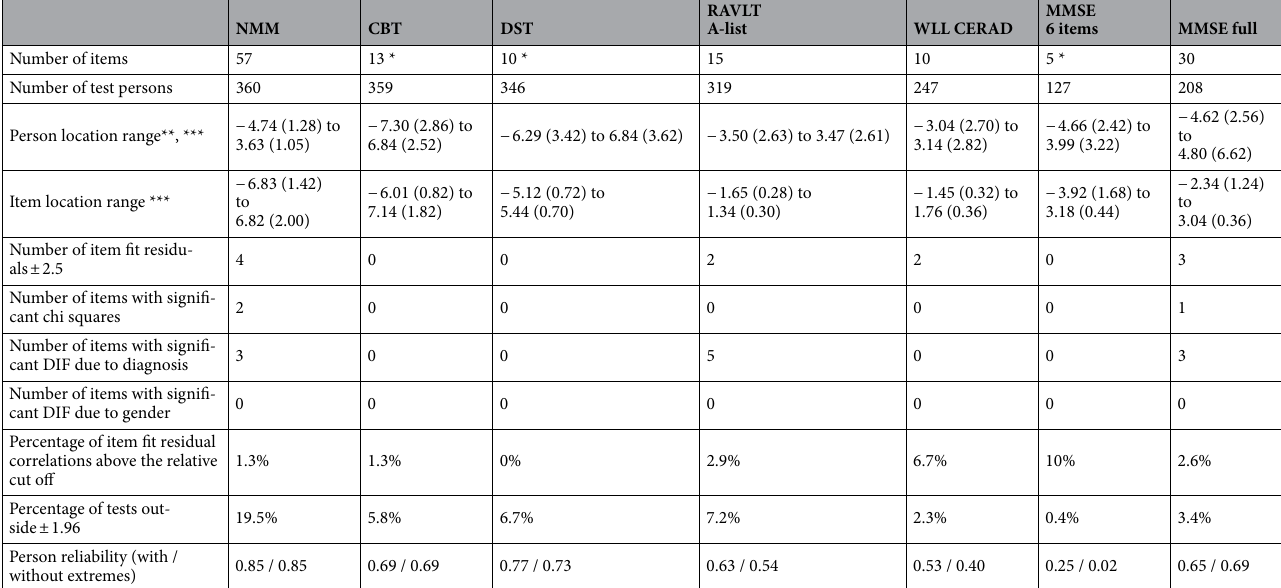
Table 2. Summary of measurement properties for the NMM and the legacy tests. The properties reported are based on individual analyses for the legacy tests (i.e., not when anchored to the NMM). * CBT, DST and MMSE 6 items had one or two items that could not be estimated in the individual analyses due to extreme items. ** Person location in logits ranges include extremes. Extremes were present for DST, RAVLT A-list, WLL CERAD, MMSE 6 items and MMSE full. *** Numbers in brackets are measurement uncertainties with coverage factor of